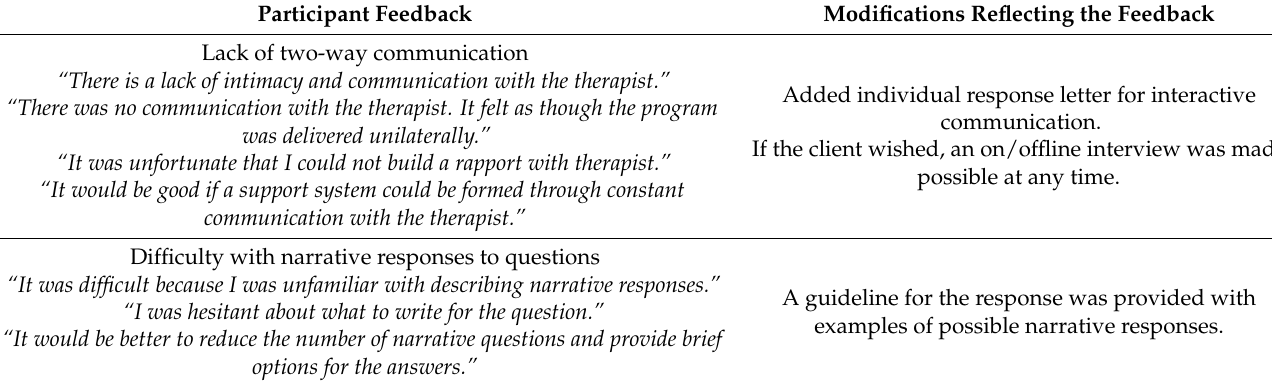
Table 1. Participant feedback and revisions to the eight-session Internet-based